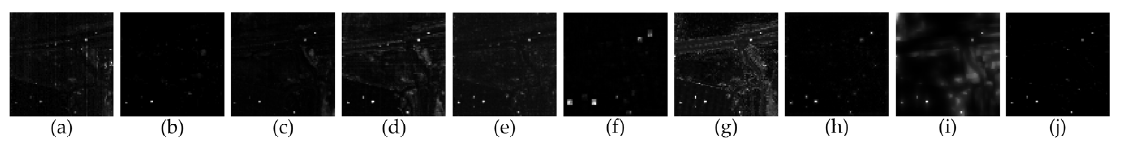
Figure 10. The detection results of different methods on the MUUFL Gulfport dataset: ( a ) RX; ( b ) LRX; ( c ) LSMAD; ( d ) LSDM–MoG; ( e ) CDASC; ( f ) 2S–GLRT; ( g ) BFAD; ( h ) SSFSCRD; ( i ) AED; ( j ) SCDF. Figure 11. The detection results of different methods on the Chikusei dataset: ( a ) RX; ( b ) LRX; ( c ) LSMAD; ( d ) LSDM–MoG; ( e ) CDASC; ( f ) 2S–GLRT; ( g ) BFAD; ( h ) SSFSCRD; ( i ) AED; ( j ) SCDF. The 3D ROC curves and the corresponding 2D ROC curves of the detection results of different methods are shown in Figures 12–15. The different AUC values calculated according to the 3D ROC curves on different datasets are shown in Tables 2–5. First, on the synthetic dataset, Figure 12 shows that the 3D ROC curve of the proposed SCDF method is relatively close to those of most alternative methods, and the corresponding 2D ROC curves (P D , τ ) and (P F , τ ) can also draw similar conclusions. The corresponding 2D ROC curve (P D , P F ) is slightly higher than those of other alternative methods. The corre- sponding AUC values are shown in Table 2. It can be seen from Table 2 that the AUC (D, F) and AUC (B, S) values of the proposed method are larger than those of the alternative meth- ods, which are 0.9982 and 0.9976, respectively. Among the alternative and proposed meth- ods, the AUC (F, τ ) = 0.00008 and AUC SNPR = 3003.0358 of the LRX method are the largest, the AUC (D, τ ) = 0.9340 and AUC TD = 1.8943 of the BFAD method are the largest, the AUC TDBS = 0.6755, and AUC ODP = 1.6650 of the AED method are the largest. Although other AUC values do not reach the maximum values, they are still relatively close to the maximum AUC values. For example, AUC (F, τ ) = 0.0005, AUC TD = 1.4833, AUC TDBS = 0.4845, and AUC ODP = 1.4828 of the proposed SCDF method are close to the corresponding optimal AUC values of 0.00008, 1.8943, 0.6755, and 1.6650.